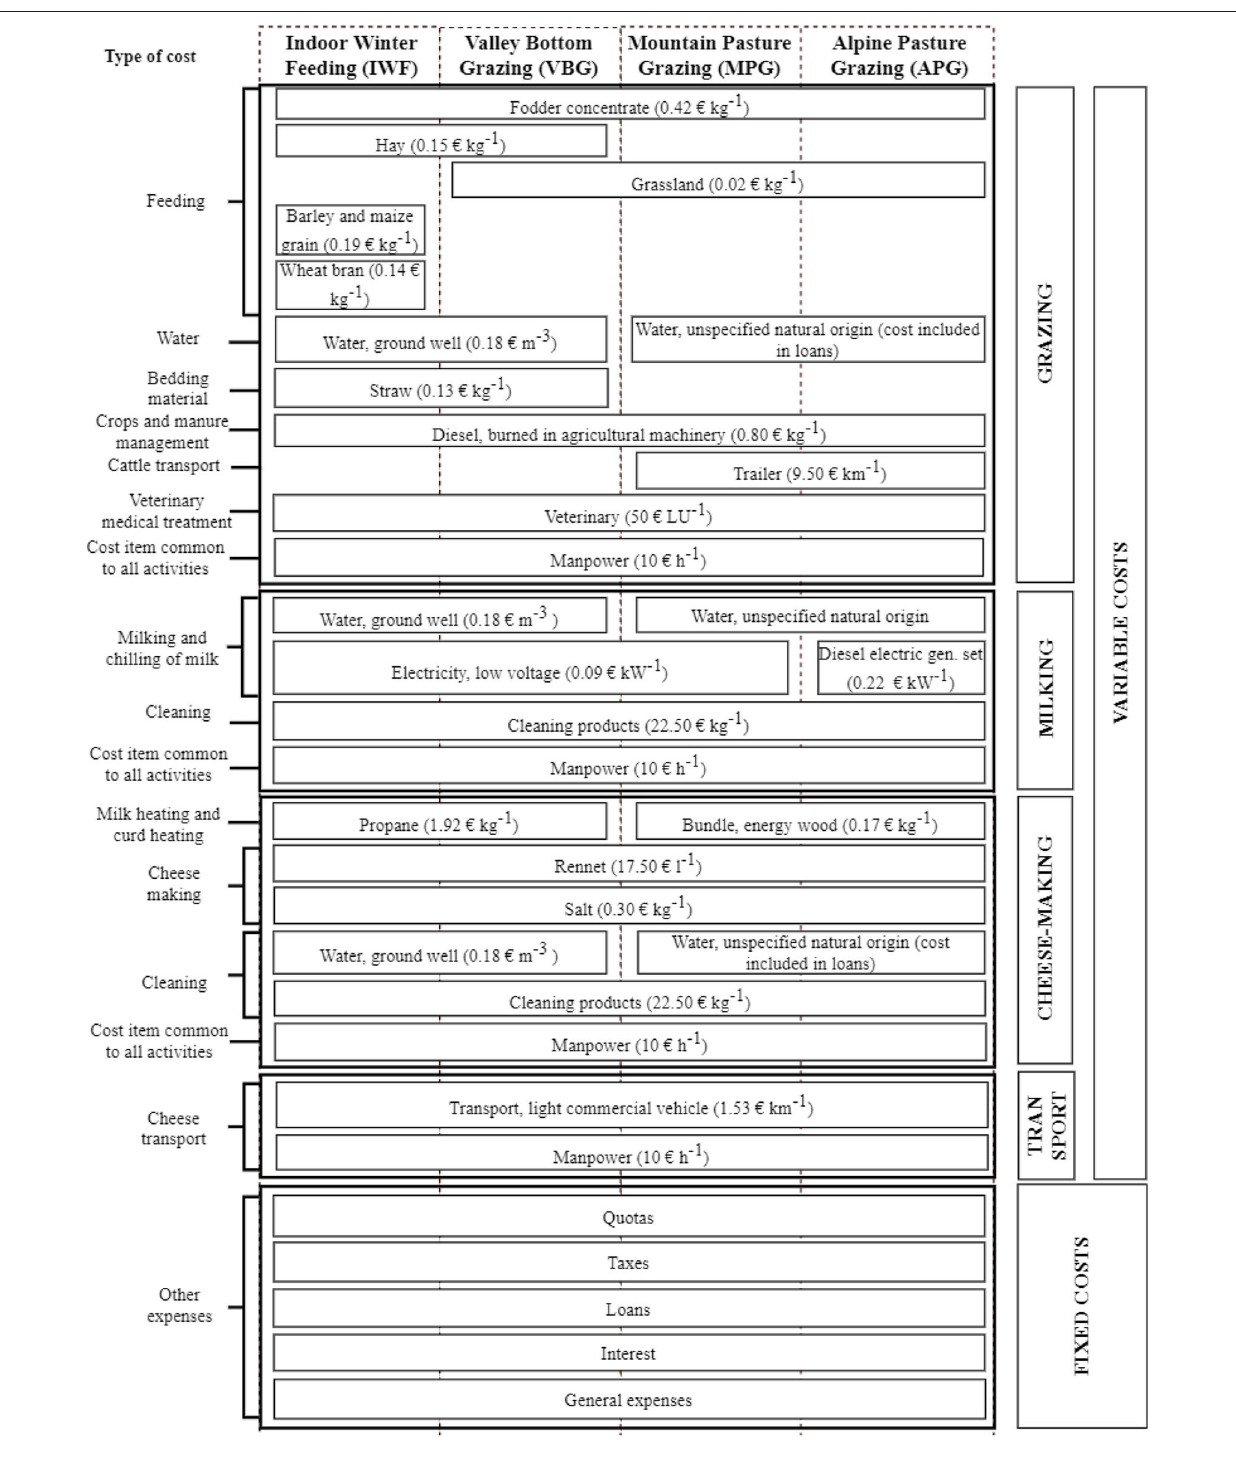
charges and contributions, the annual membership fee of the consortium for the protection of the Toma di Lanzo cheese and administrative